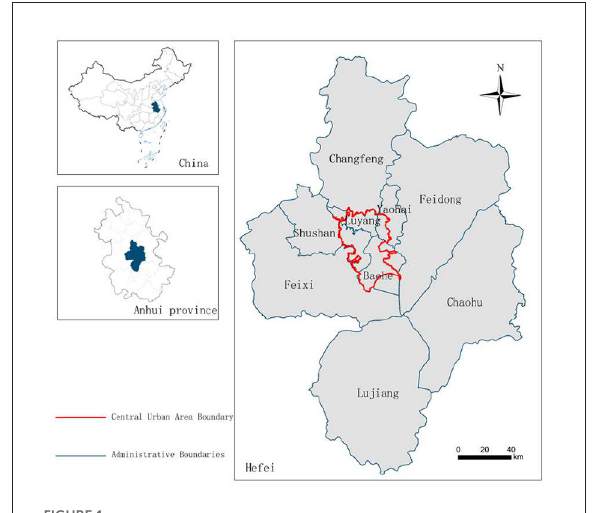
FIGURE1 Central urban area of Hefei.